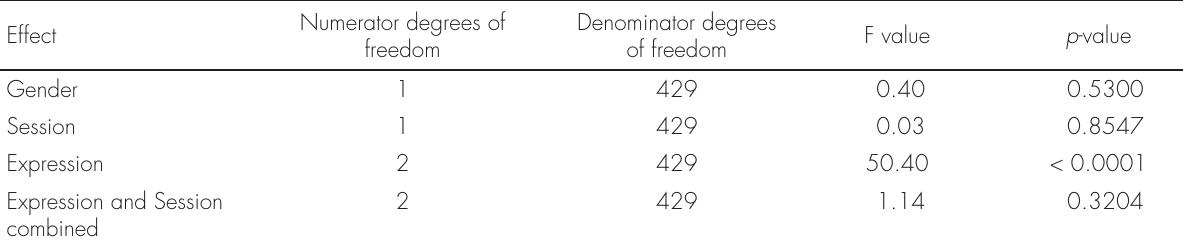
Table IV. Analysis of covariance for overall facial asymmetry